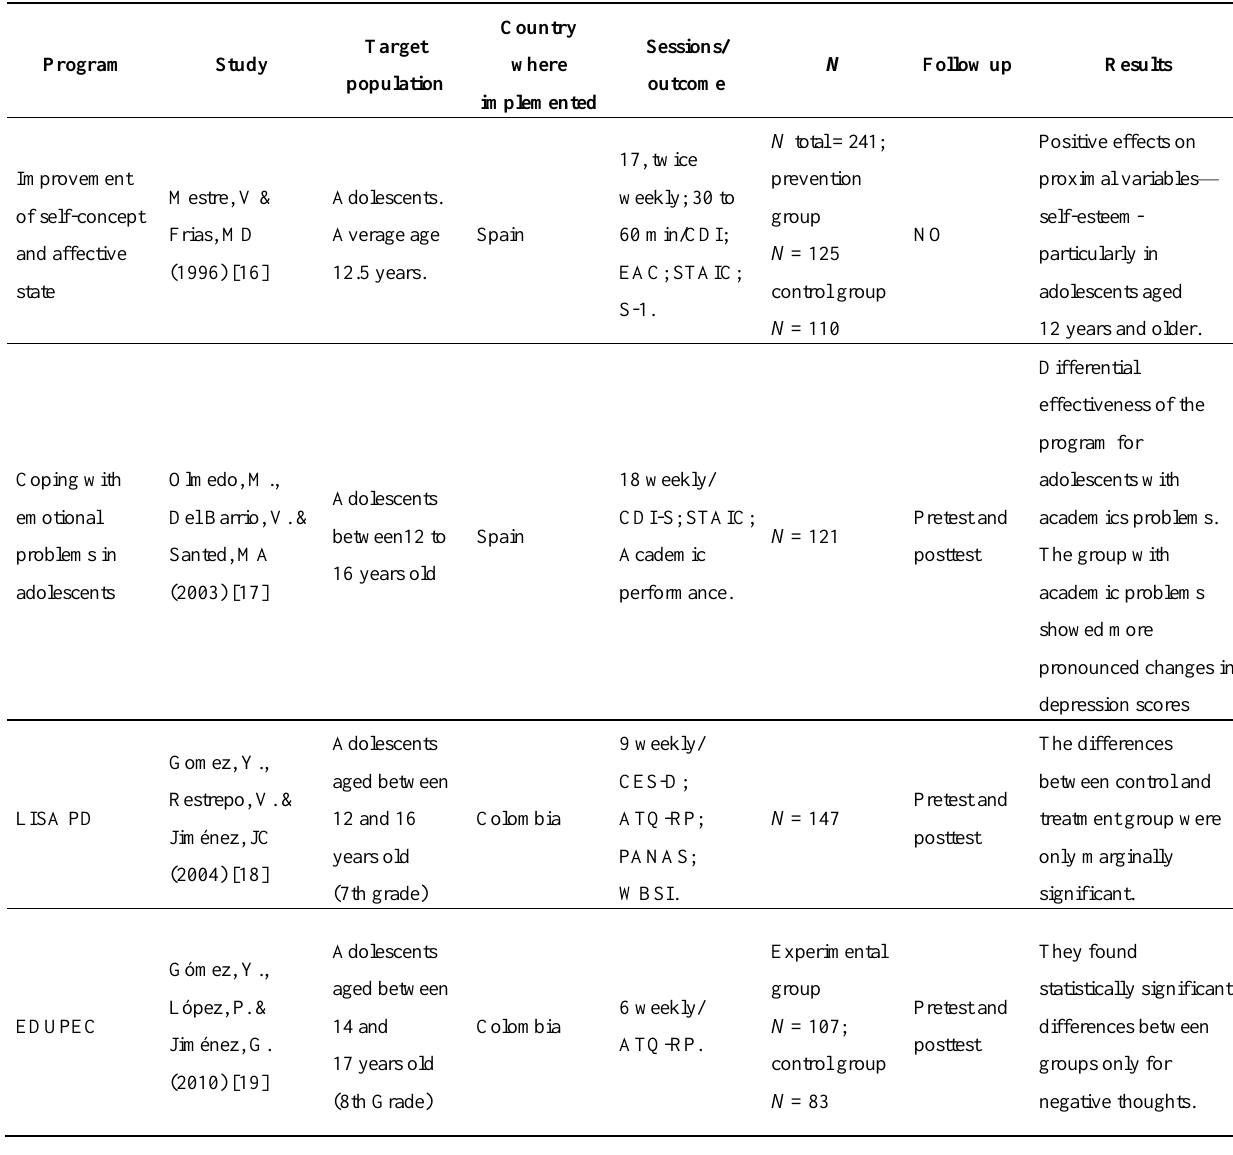
Table 1. Included prevention